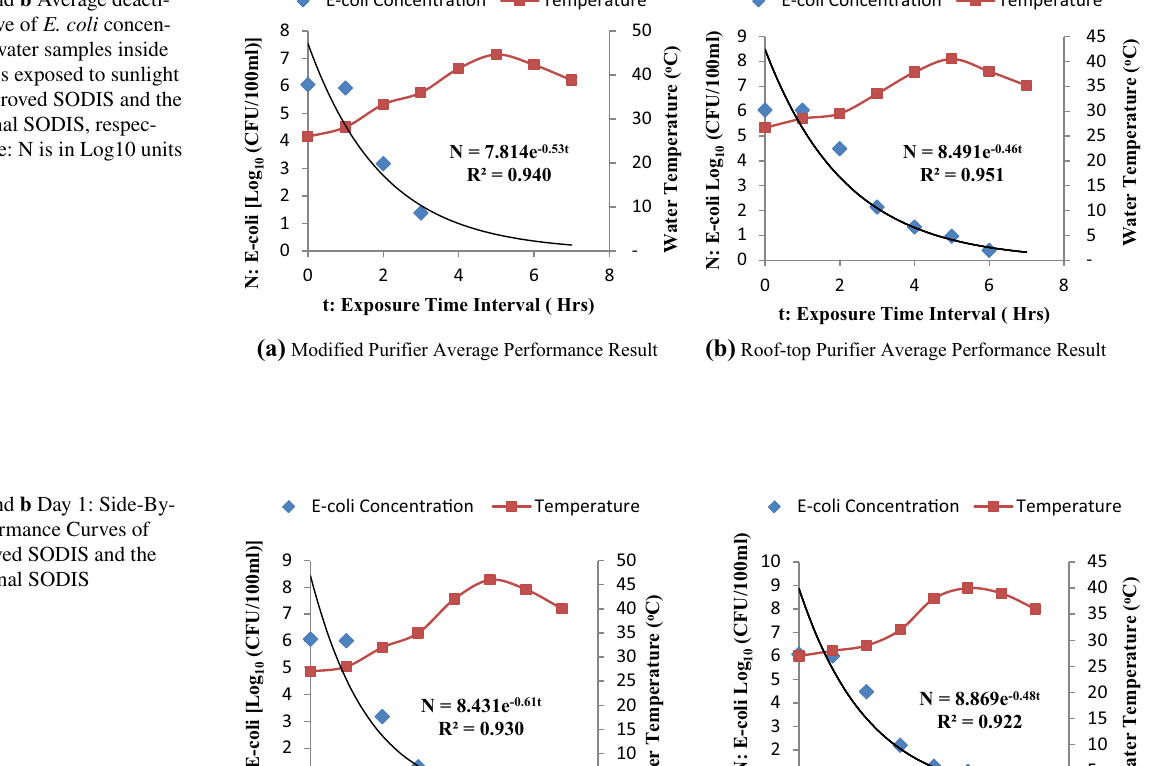
N = 8.431e -0.61t R² = 0.930